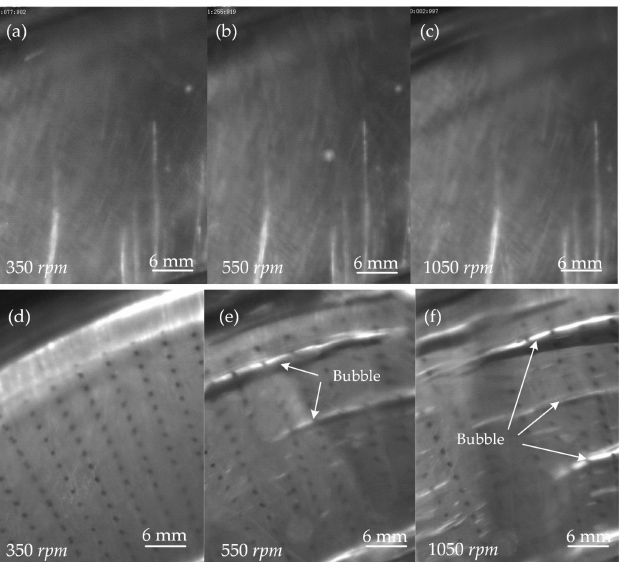
Figure 32. Cavitation morphology on non-textured friction disk and textured friction disk (( a ) is cavi- tation morphology on non-textured friction disk when speed is 350 rpm; ( b ) is cavitation morphology on non-textured friction disk when speed is 550 rpm; ( c ) is cavitation morphology on non-textured friction disk when speed is 1050 rpm; ( d ) is cavitation morphology on textured friction disk when speed is 350 rpm; ( e ) is cavitation morphology on textured friction disk when speed is 550 rpm; ( f ) is cavitation morphology on textured friction disk when speed is 1050 rpm; The arrows in ( c ) and ( d ) indicate the location of the cavitation